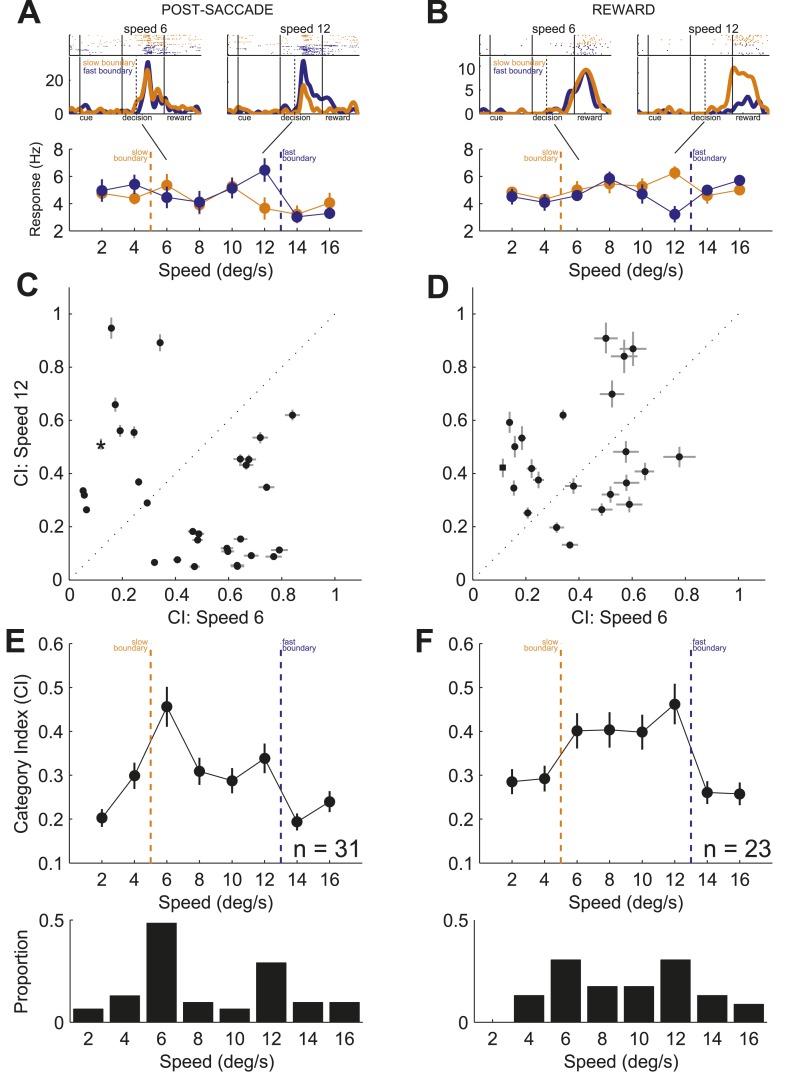
Representation of category signals.(A) Example neurons with activity during post-saccade (A) and reward (B) periods. (top) Spike raster plots, each row is one trial and each dot is detected spike, and spike density functions (mean ± SEM) in response to speeds 6 (left) and 12 (right). Black lines show periods of the task. Dashed black lines indicate average reaction time to saccade. (bottom) Average neuronal activity across stimuli sorted by the boundary position. Orange/blue dashed lines, actual boundary positions. Bars, SEM. (C and D) Scatter plots of CIs for speed 6 vs speed 12 across neurons with activity during post-saccade (C, n = 31) and reward (D, n = 23) periods. Example neurons in (A and B), star and square in (C and D), respectively. (E and F) (top) Average CI across speeds for neurons with activity during post-saccade (E) and reward (F) periods. (bottom) Proportion of neurons with a significant difference between spike counts across boundaries for each speed (bootstrap test, p < 0.05).